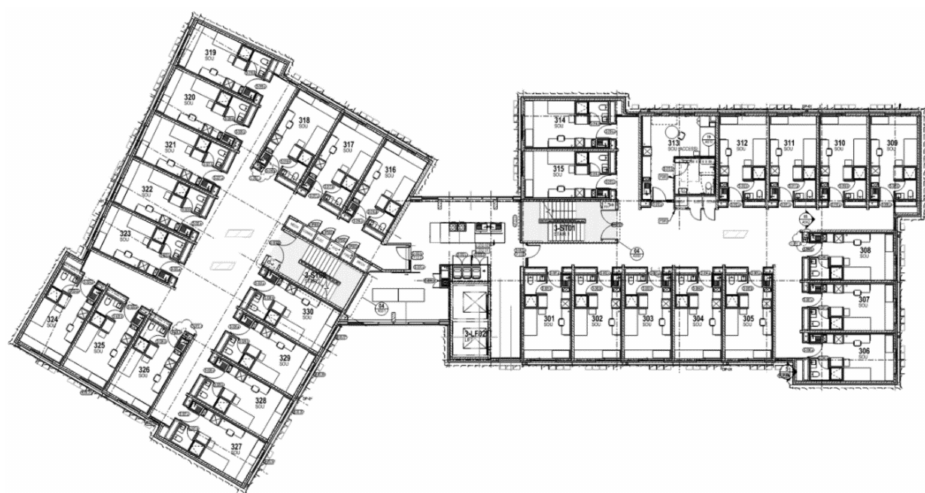
Figure 2. Floor plan of the case study building, Gillies Hall (retrieved from Jackson Clements Burrows Architects).